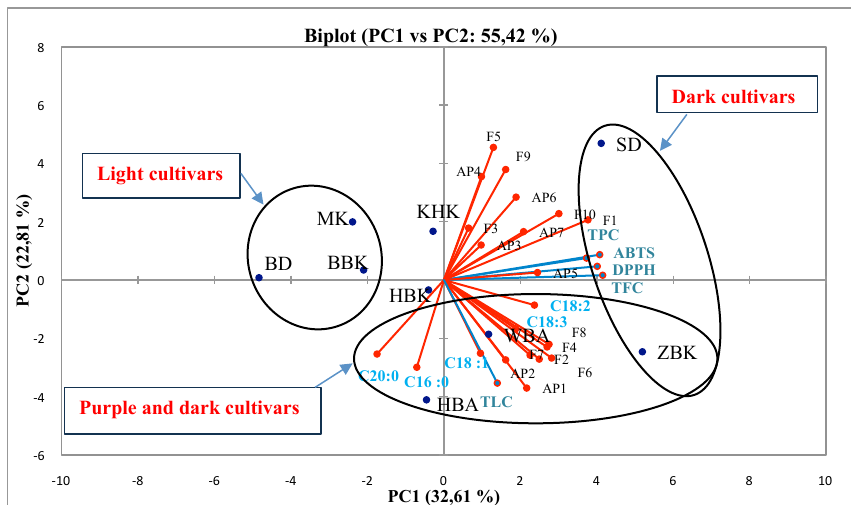
Fig. 4: Principal component analyses of nine dry fig Tunisian cultivars. Flavonoids: Rutin (F1), Luteolin-7-o-glucoside (F2), Naringin (F3), Apigenin-7-o- glucoside (F4), Quercetin (F5), Kaempferol (F6), Naringenin (F7), Apigenin (F8), Luteolin (F9), Cirsiliol (F10), and phenolic acids: Gallic acid (AP1), Protocatechuic acid (AP2), 4-O-Caffeoylquinic acid (AP3), p-Coumaric acid (AP4), trans Cinnamic acid (AP5), trans Ferulic acid (AP6), Salviolinic acid (AP7).